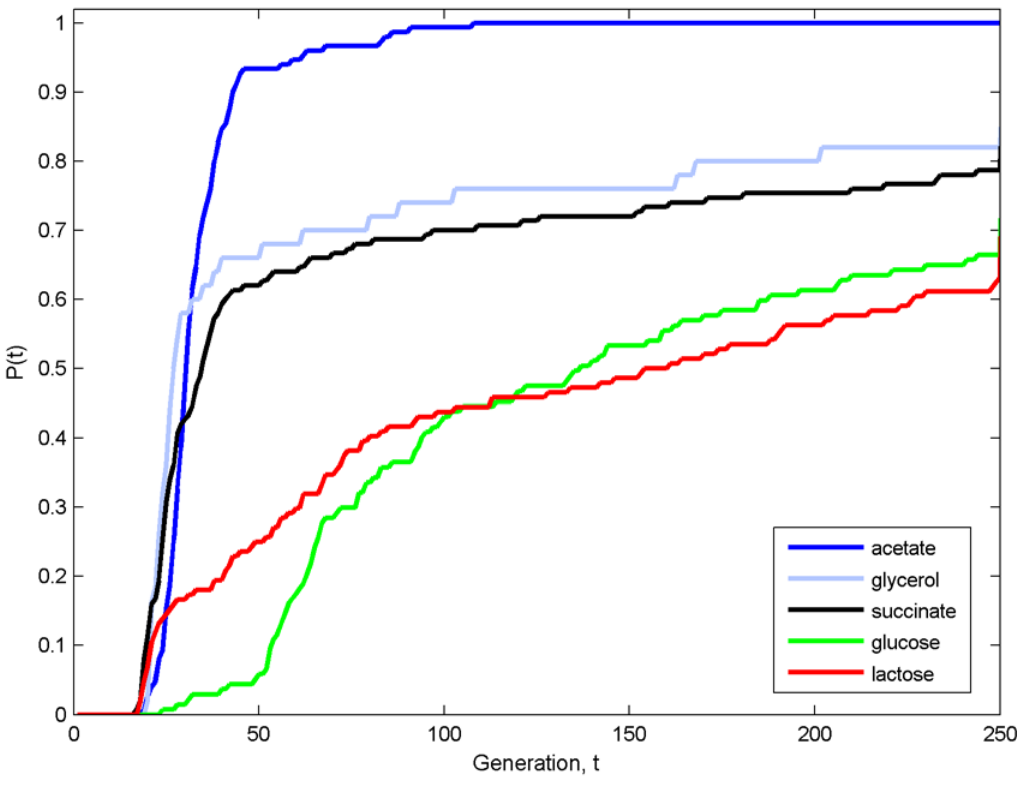
Figure 5. Outcome of in silico adaptive evolution of E. coli populations in different environments. The fraction P ( t ) of evolving populations that found the highest-fitness phenotype at (or before) the t th generation is plotted against t .